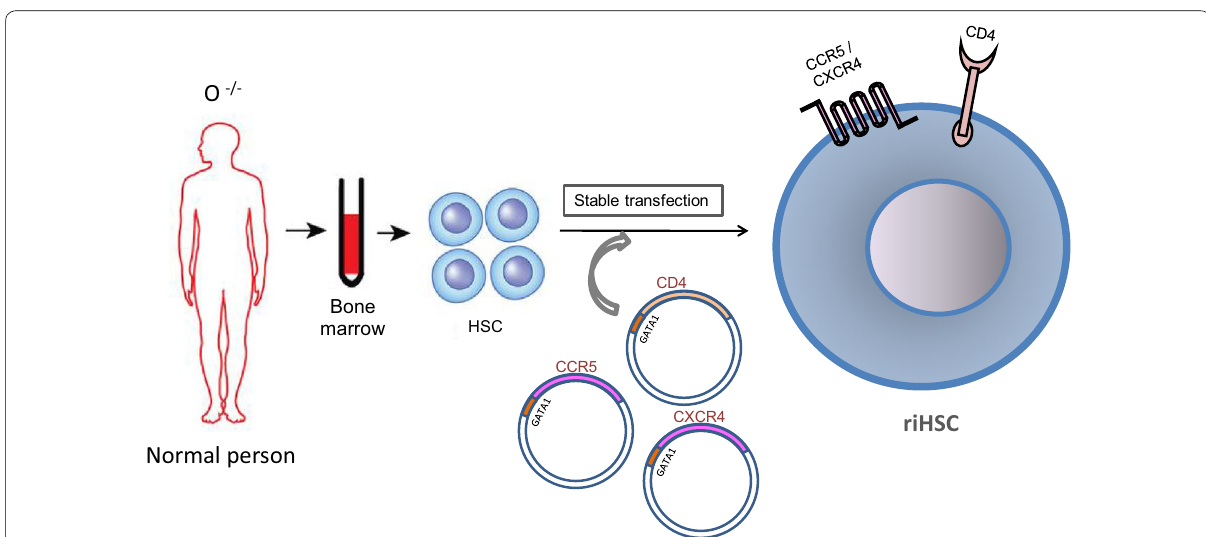
Fig. 1 HIV receptor integrated hematopoietic stem cell formation. Hematopoietic stem cells can be collected from healthy person having O-negative (O − / − ) blood group. HIV receptor-CD4 and co-receptors-CCR5 and CXCR4 will then be transgenically introduced onto the hematopoi- etic stem cell membranes by stably transducing or transfecting HSC with receptor genes under GATA-1 promoter control to form riHSC using viral or non-viral vectors. These receptor positive stem cells will be sorted using HIV receptors for next treatment. HIV human immunodeficiency virus, HSC hematopoietic stem cell, CD4 cluster of differentiation 4, CCR5 C-C chemokine receptor type 5, CXCR4 C-X-C chemokine receptor type 4, riHSC receptor-integrated hematopoietic stem